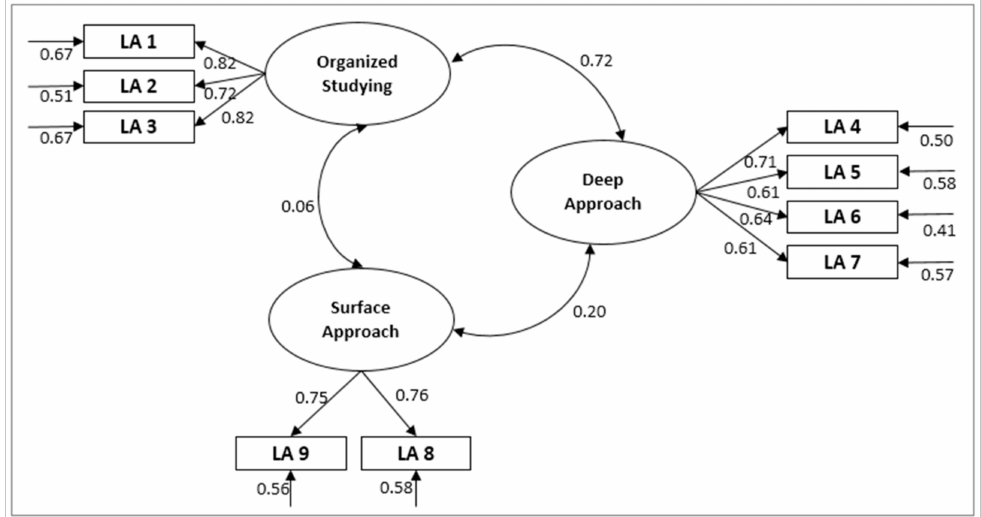
Figure 2. Measurement model for student approaches to learning factors ( b ).